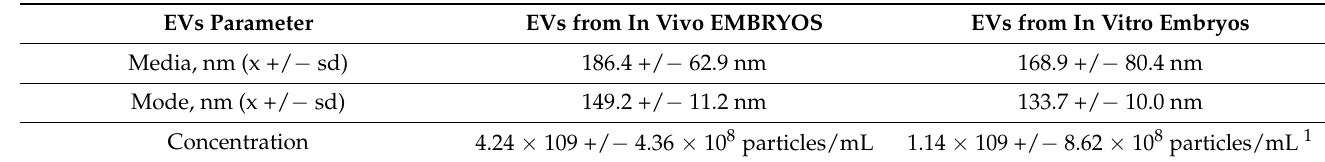
Table 2. Evaluation of surface markers CD63, CD40, CD9, and CD81 in EVs secreted during blastula- tion by bovine embryos produced in vitro or in vivo.